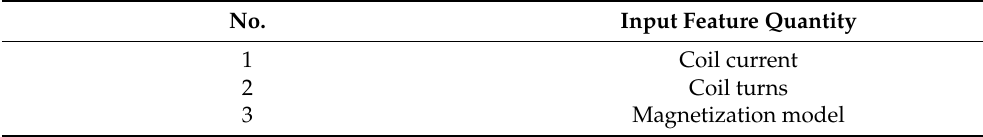
Table 1. Three input feature quantities.